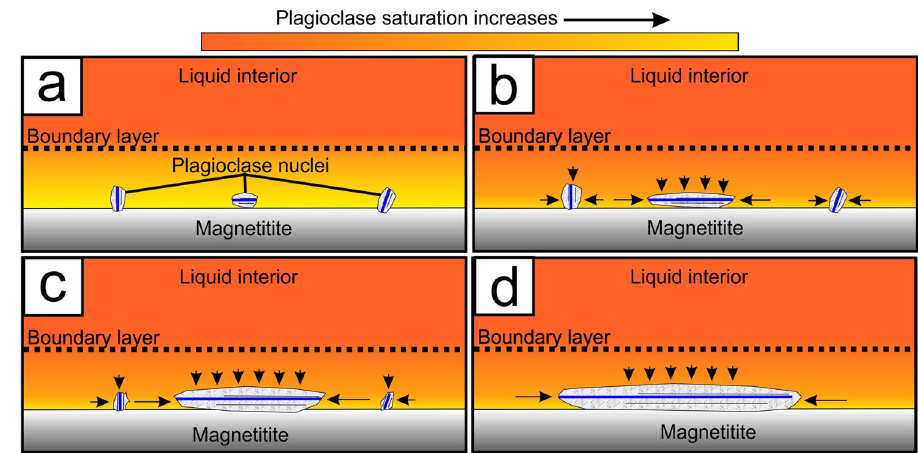
Fig. 8 Origin of foliated plagioclase grains in magnetitite. a Due to the extraction of magnetite components from the melt during magnetite crystallization, a liquid boundary layer forms with the highest degree of plagioclase saturation (indicated by yellow color) located directly at the crystal – liquid interface. This allows plagioclase grains to nucleate heterogeneously at the bottom of the boundary layer with different orientations. Random orientations for heterogeneously nucleated crystals appear to be possible based on recent observations on chromitite layers 15 . Blue lines indicate the orientation of the a-axis of plagioclase grains along which growth is generally faster 65 . b As the plagioclase grains start growing, the degree of plagioclase saturation within the boundary layer starts to drop. Since the melt directly above the plagioclase contains a lower concentration of plagioclase components, growth is limited in an upward direction, and the diffusive fl ux of crystal nutrients (indicated by the size of the black arrows) is greater from the sides. The plagioclase grain in the center with its faster-growing faces oriented perpendicular to the solidi fi cation front thus manages to grow faster than the other grains, causing it to become elongated parallel to the a-axis. c As nutrients diffuse towards the faster-growing crystal, grains with less favorable orientations begin to dissolve. d With time, mostly grains with their a-axis parallel to the solidi fi cation front